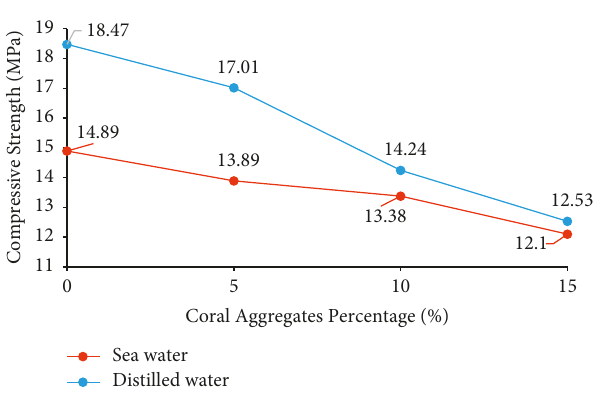
Figure 6: Compressive strength of